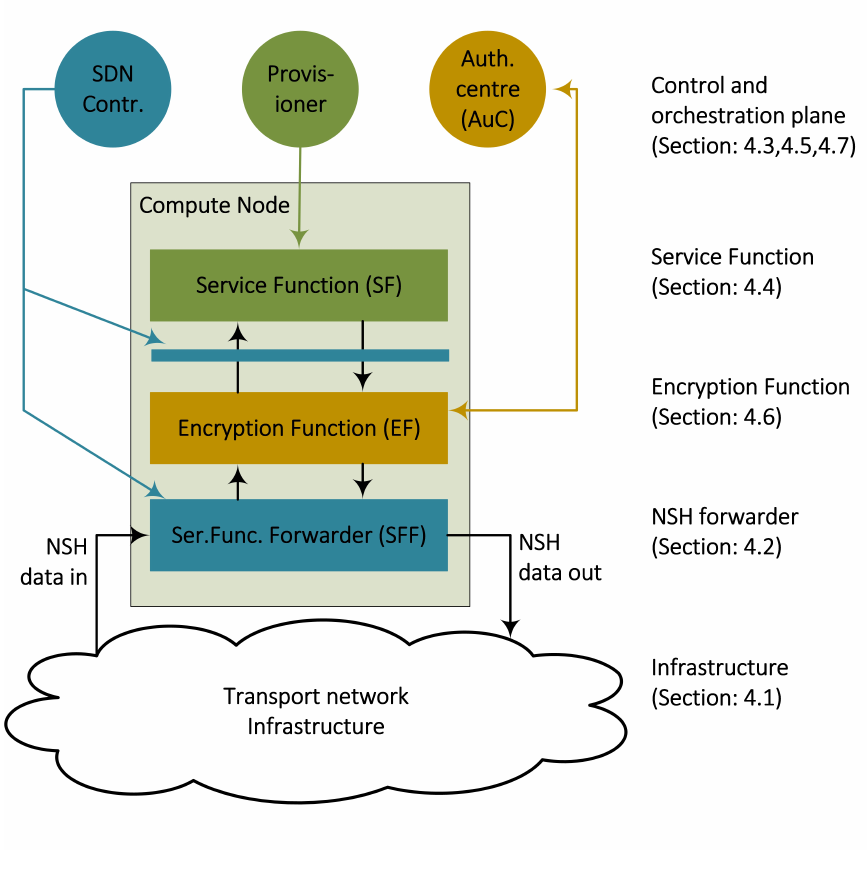
Figure 3. Top-level